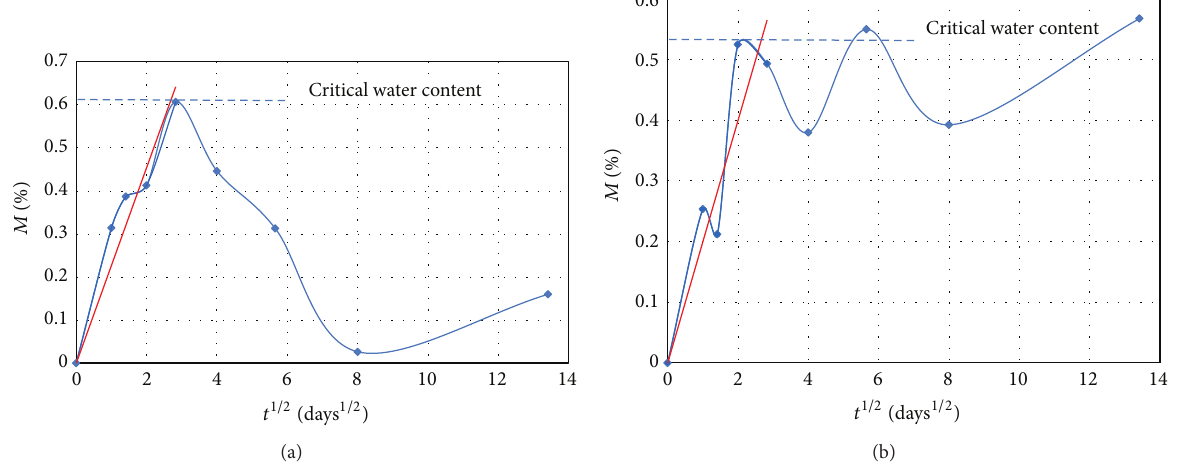
Figure 2: Water absorption curves as a function of specimen immersion time: (a) polyurethane and (b)